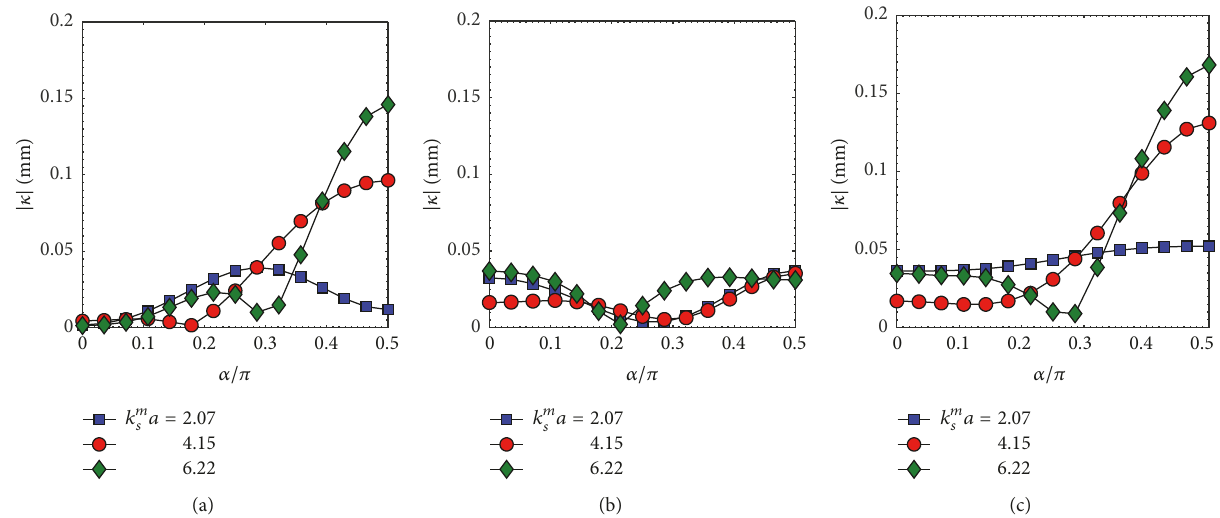
Figure 12: The sensitivity of 𝜎 𝑠 to (a) 𝐾 𝑛 and (b) 𝐾 𝑡 and (c) both 𝐾 𝑛 and 𝐾 𝑡 , under the SV-wave incidence. 𝐾 𝑡 /𝐾 ∗ 𝑡 = 1 in (a), 𝐾 𝑛 /𝐾 ∗ 𝑛 = 1 in (b), and 𝐾 𝑛 /𝐾 ∗ 𝑛 = 𝐾 𝑡 /𝐾 ∗ 𝑡 in